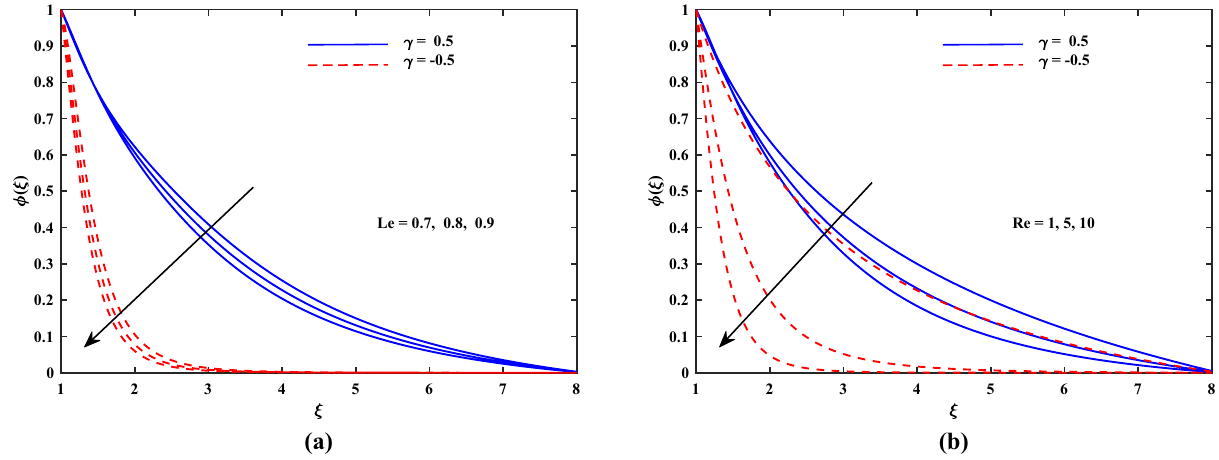
Figure 5. Plot for concentration profile φ(ξ) with varying values of Le and Re .